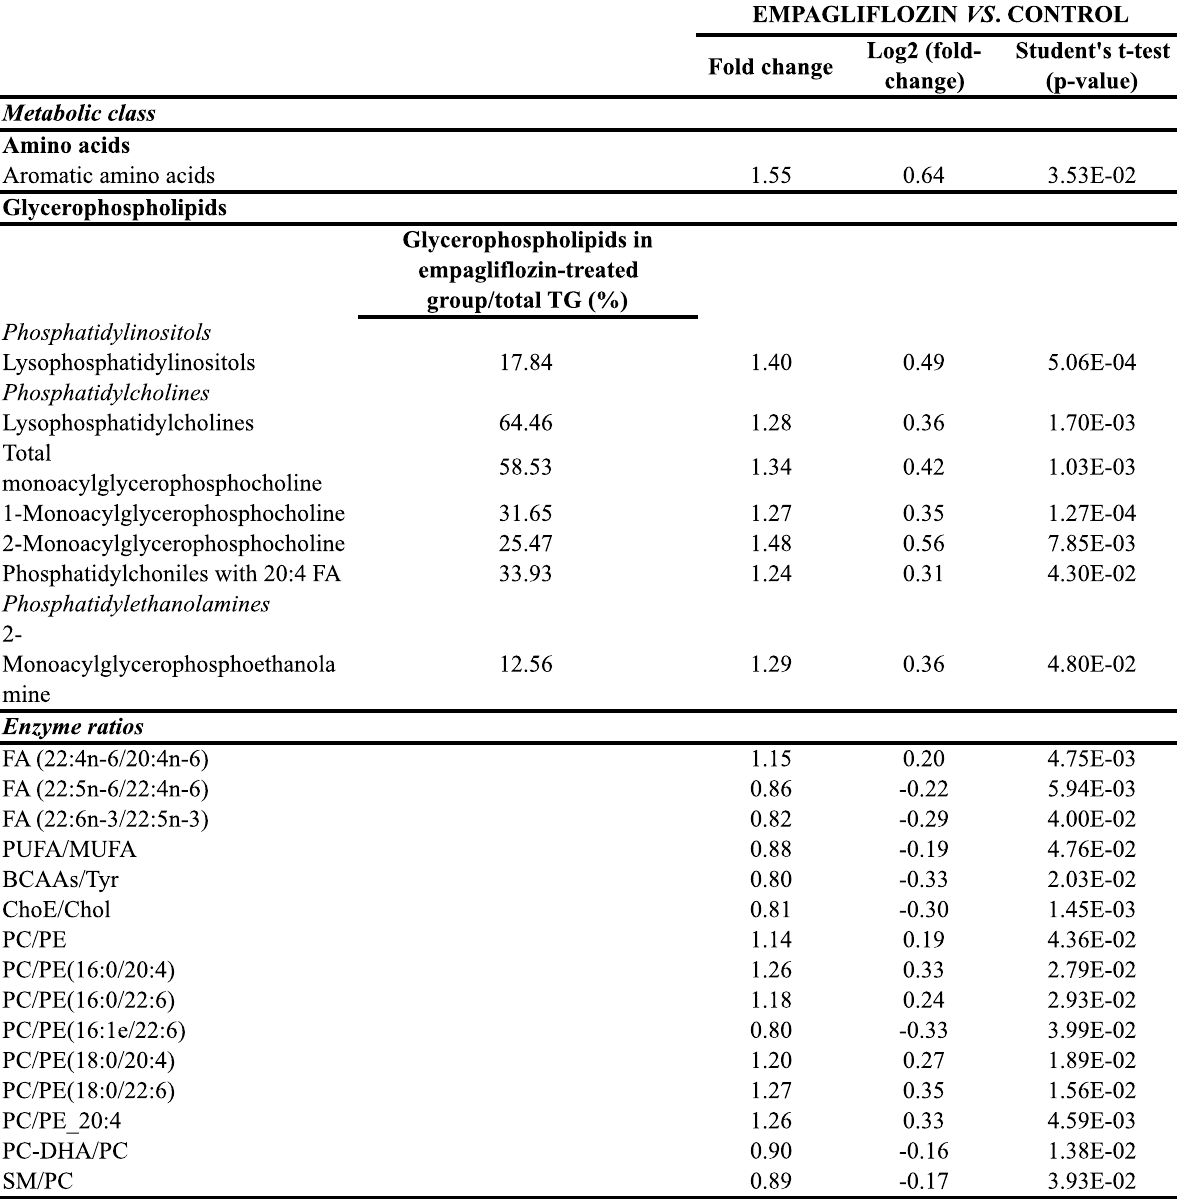
TABLE 1 | Signi fi cantly altered metabolic classes and enzyme ratios in liver from empagli fl ozin-treated rats compared to control rats. TG, triacylglycerides; FA, fatty acids; PUFA, polyunsaturated fatty acids; MUFA, mono-unsaturated fatty acids; BCAAs, branched chain amino acids; ChoE, cholesteryl esters; Cho, cholesterol; PC, phosphatidylcholines; PE, phosphatidylethanolamines; DHA, docosahexaenoic acid; SM, sphingomyelin.